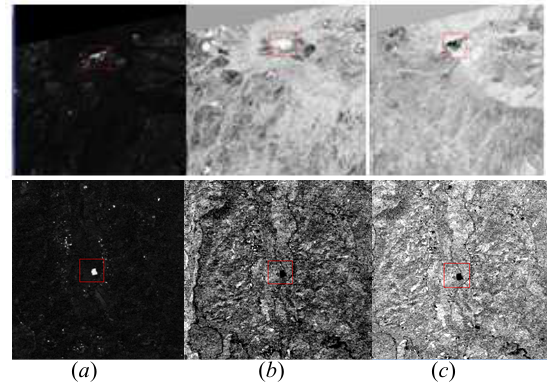
Figure 4. Detail of RX spectral anomalies (a), Alunite (b) and Illite (c), from 2005 HyMAP image in Turrialba crater (top). Detail RX spectral anomalies (a), Alunite (b) and Illite (c), from 2005 MASTER image on manmade cover